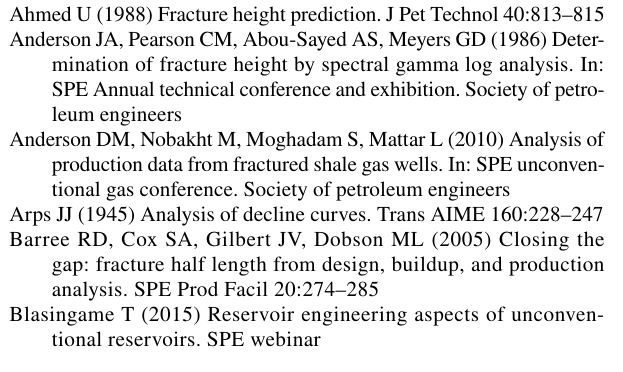
gap: fracture half length from design, buildup, and production analysis. SPE Prod Facil 20:274–285